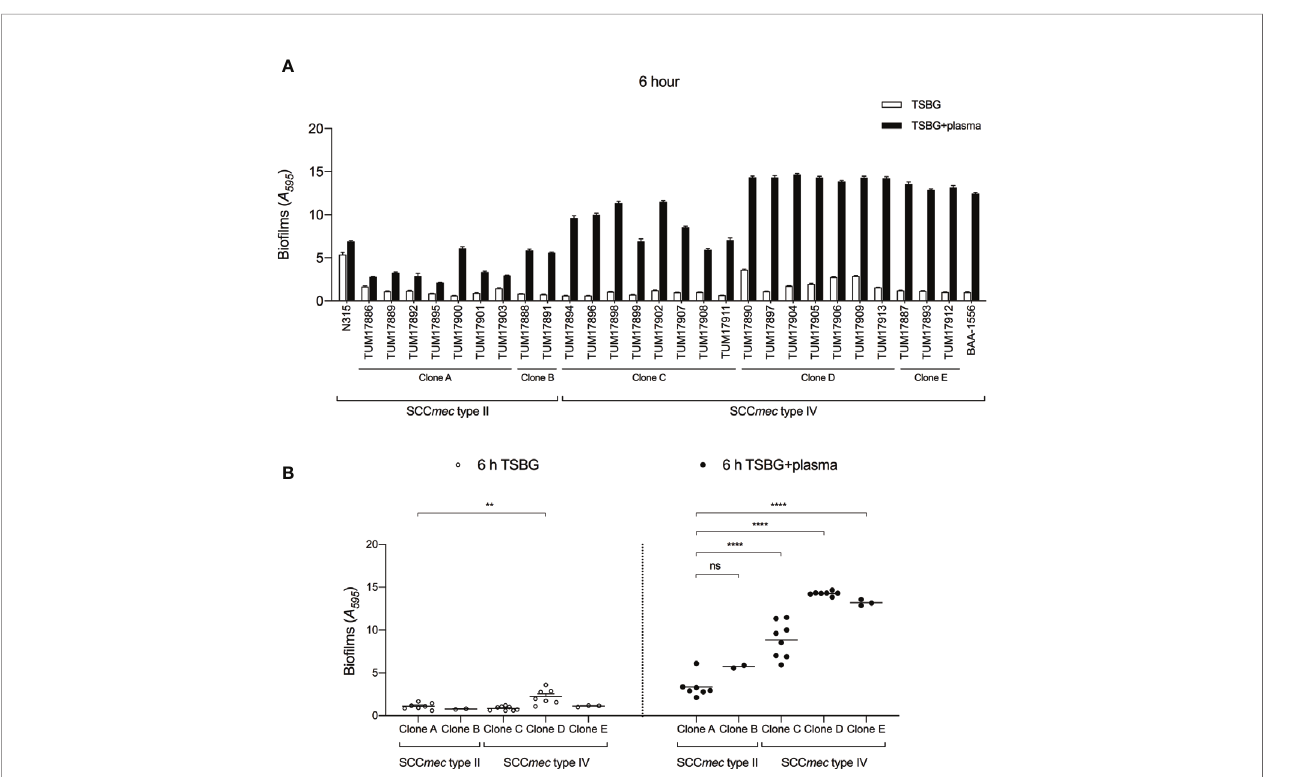
FIGURE 2 | Quanti fi cation of bio fi lms by crystal violet (CV) staining assay. (A) Amount of bio fi lm formation of each strain with or without plasma. (B) Comparison of bio fi lm formation between clones. Three wells were used for each strain per experiment, and the experiment was conducted three times. Data from the total of nine experiments were compared between strains. ** p < 0.005, **** p < 0.0001; one-way ANOVA followed by Tukey ’ s multiple comparison test was used in (B) . TSBG, tryptic soy broth containing 0.5% glucose; ns, not signi fi